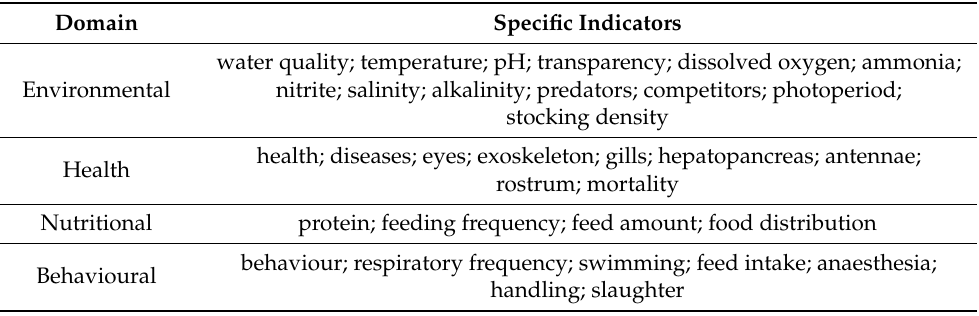
Table 1. Specific indicators used to obtain bibliographic data to define the reference values for the four domains of marine shrimp welfare studied. Domain Specific